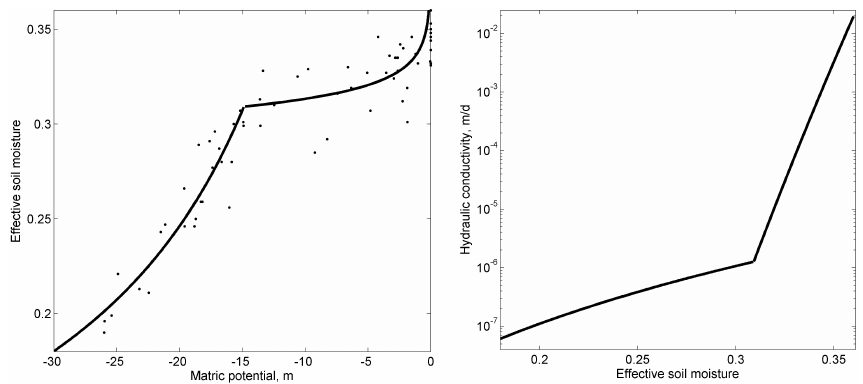
Figure 3. Chalk soil moisture retention fit using a dual Brooks and Corey curve and the corresponding hydraulic conductivity dependence on effective soil moisture. Black dots are observed